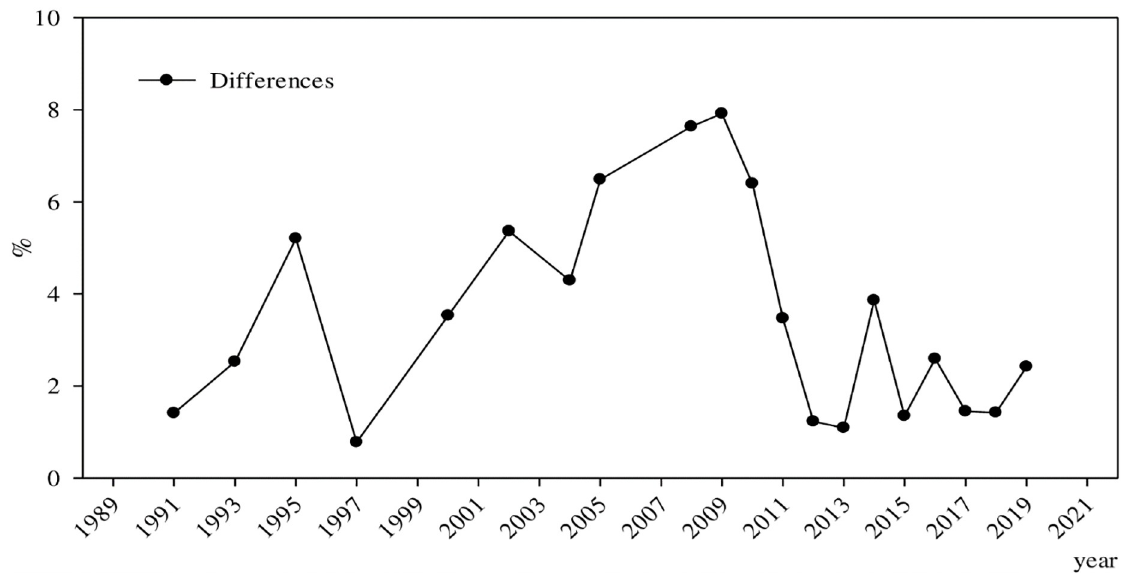
Fig 4. Robustness test: Evolution of the differences in returns to education between urban and rural China. Data Source : CHNS, CHIP, CGSS, CFPS, CHFS, and CSS.